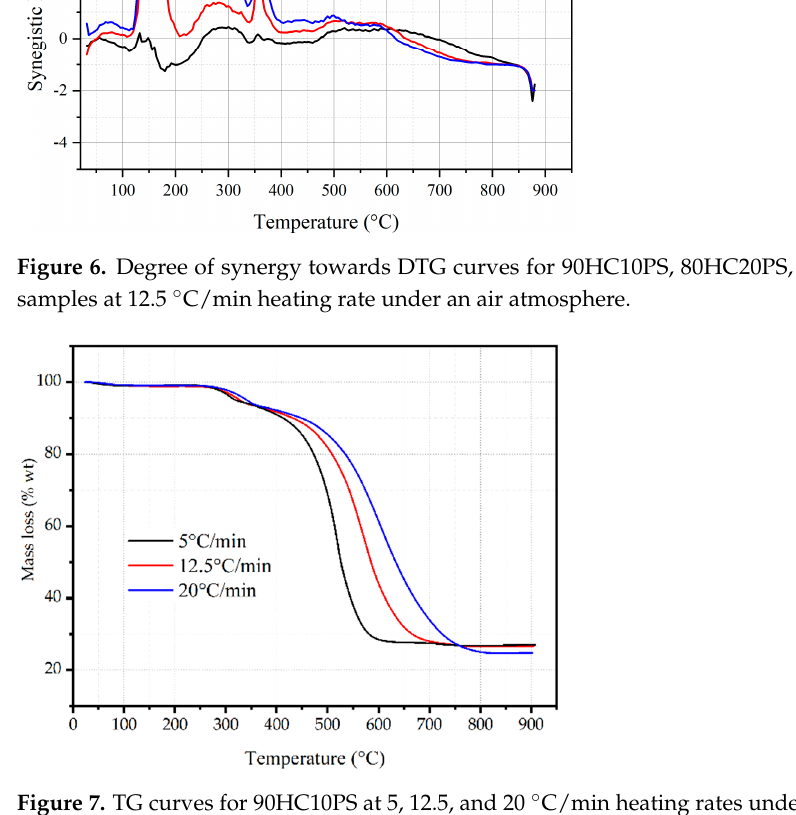
Figure 6. Degree of synergy towards DTG curves for 90HC10PS, 80HC20PS, and 70HC30PS fuel samples at 12.5 °C/min heating rate under an air atmosphere.